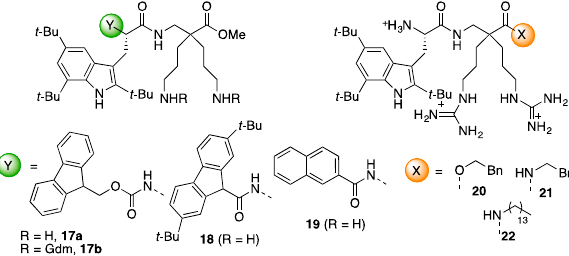
Figure 4. Pharmacomodulation of antimicrobial peptide.